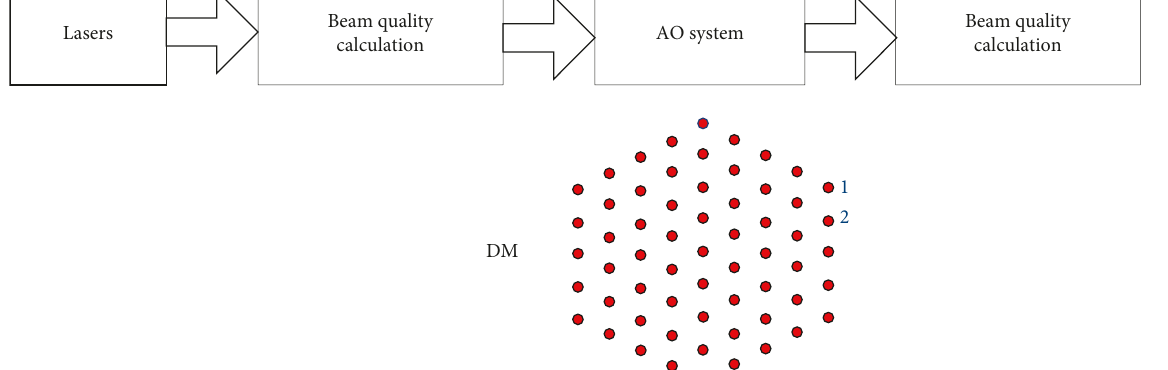
Figure 3: Schematic diagram of the model.